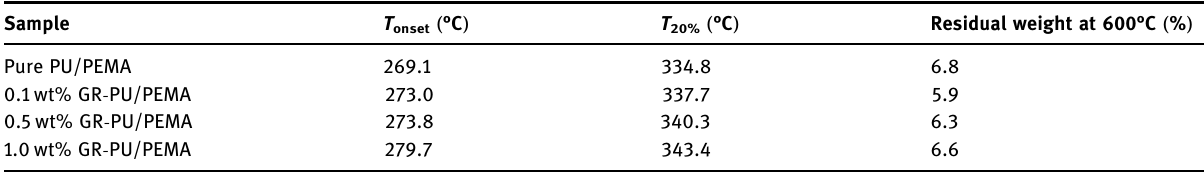
Table 3: Characteristic DTG data of GR - PU/PEMA IPN composites